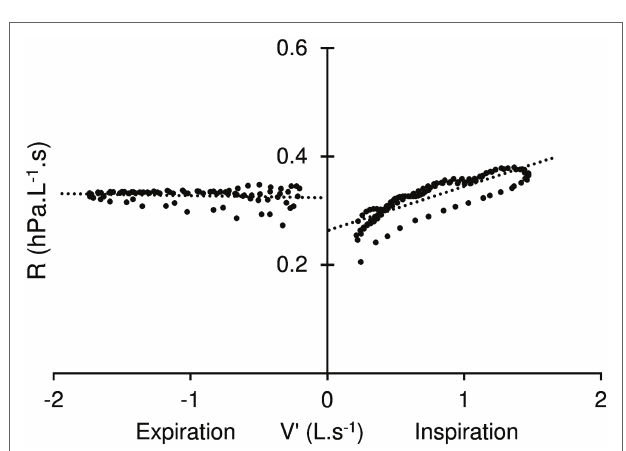
FIGURE 3 | Resistance (R) – Flow (V ′ ) diagram. Positive flow dependence, more apparent in inspiration (positives values of V ′ ) than expiration is indicated by dotted line. K1 (the resistance extrapolated at zero flow) is represented by the intersection with V ′ axis. Also note some looping in the relationship during both inspiration and